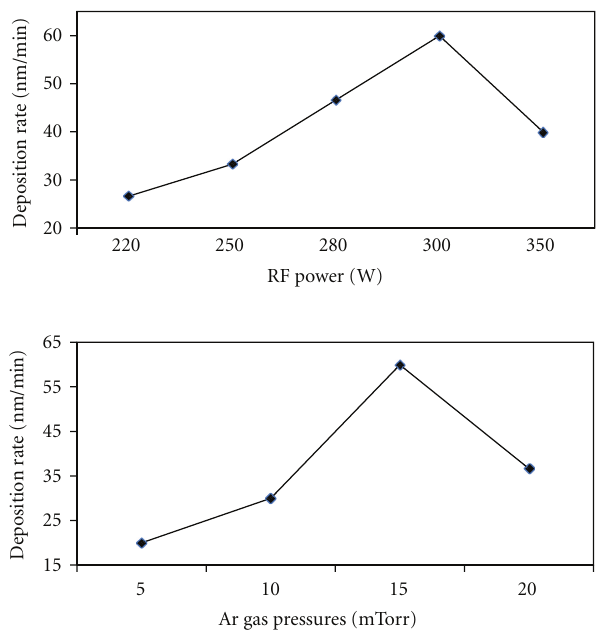
Figure 3: Deposition rate of ITiO film at various RF